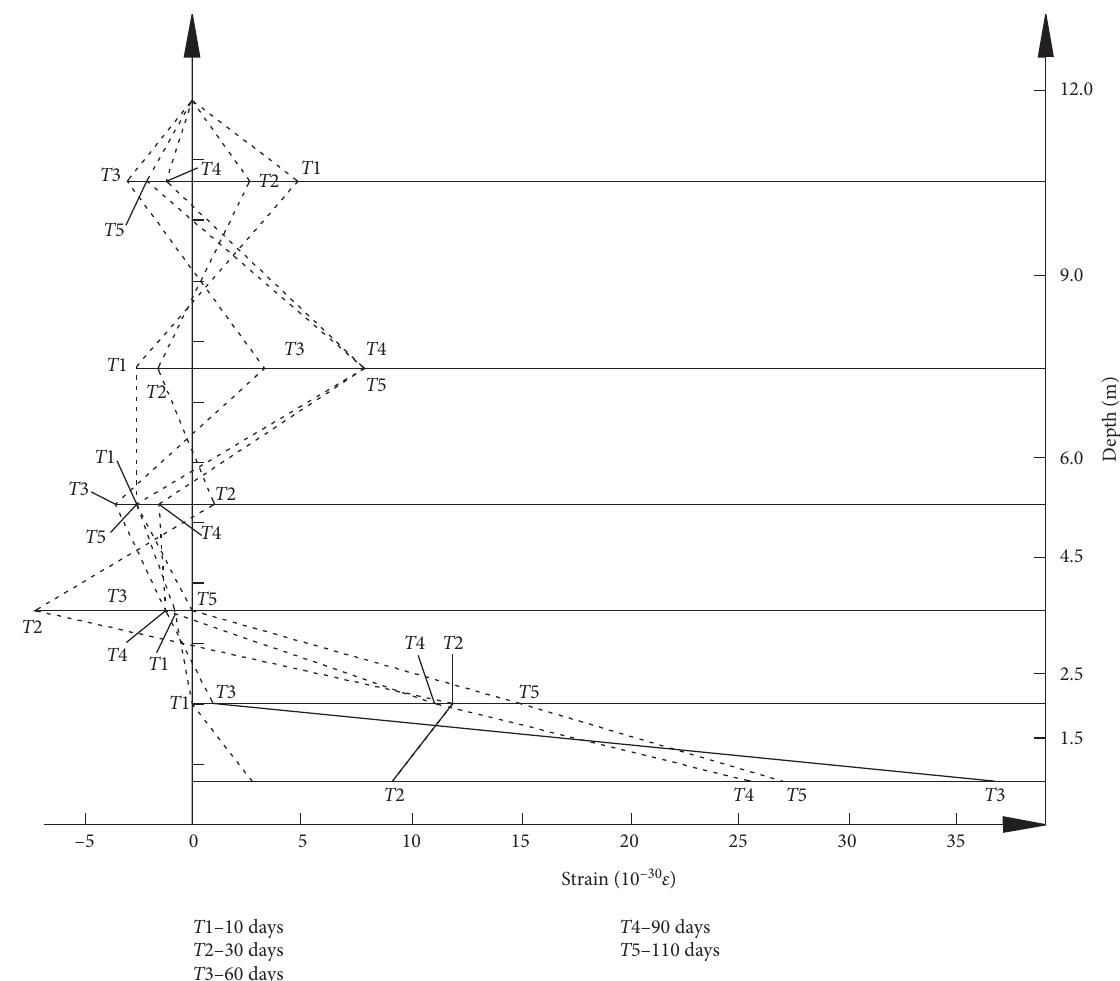
Figure 3: Tensile and compressive strain changed with time and hole depth in the surrounding rock